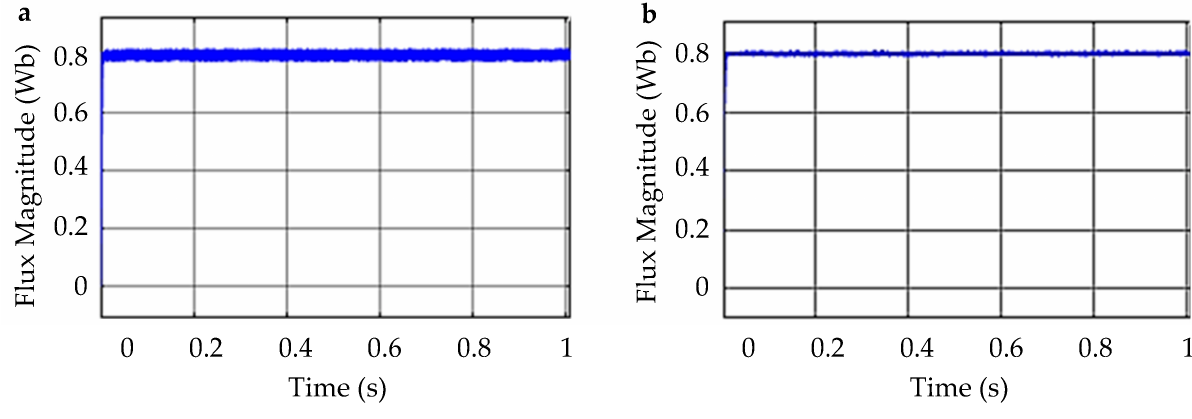
Figure 14. Flux magnitude under load during startup and steady state.